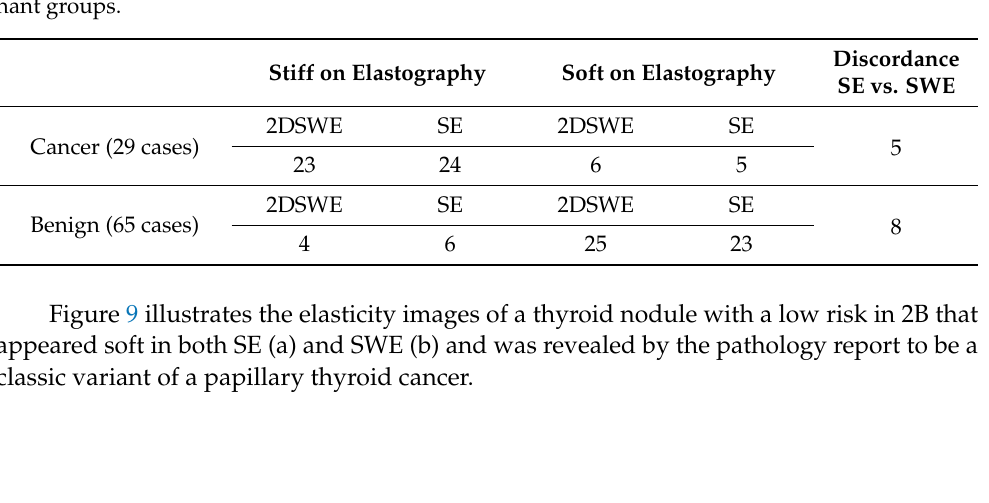
Table 8. Concordance of SE (strain ratio) versus 2D-SWE (Mean EI) in the benign and malig- nant